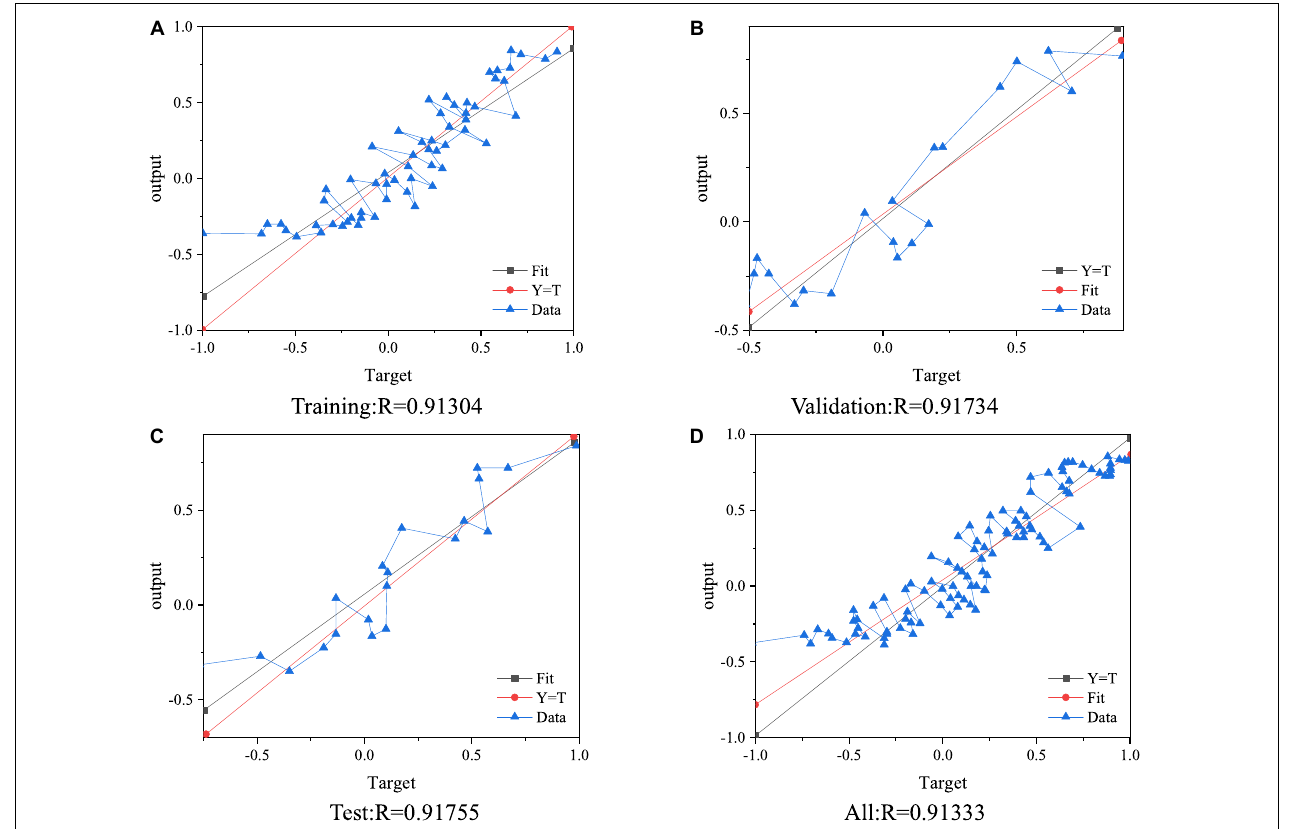
FIGURE 11 | BPNN linear regression processing. (A) Training: R = 0.91304. (B) Validation: R = 0.91734. (C) Test: R =0.91755. (D) All: R =0.91333.